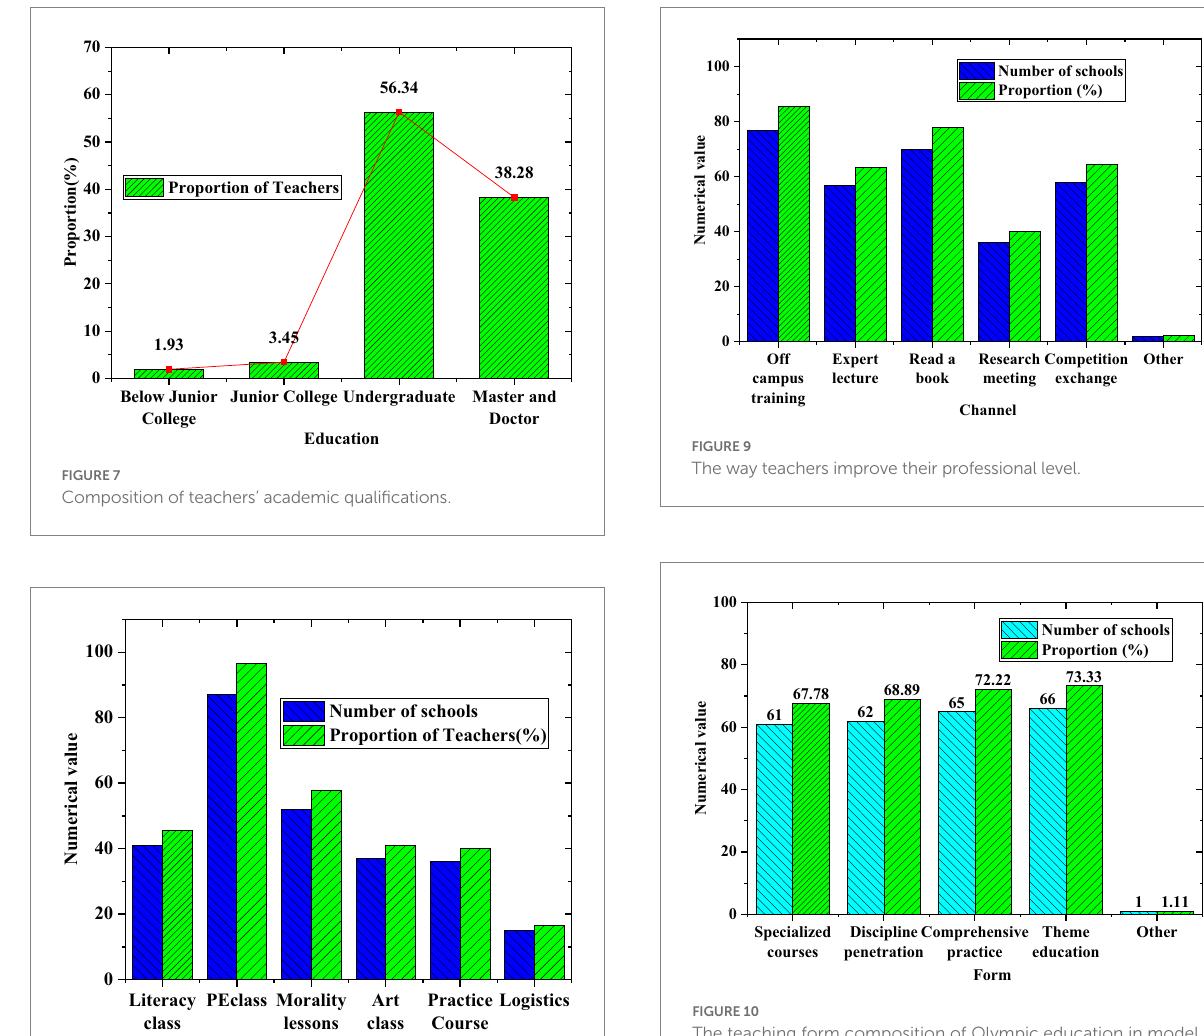
FIGURE 10 The teaching form composition of Olympic education in model schools.